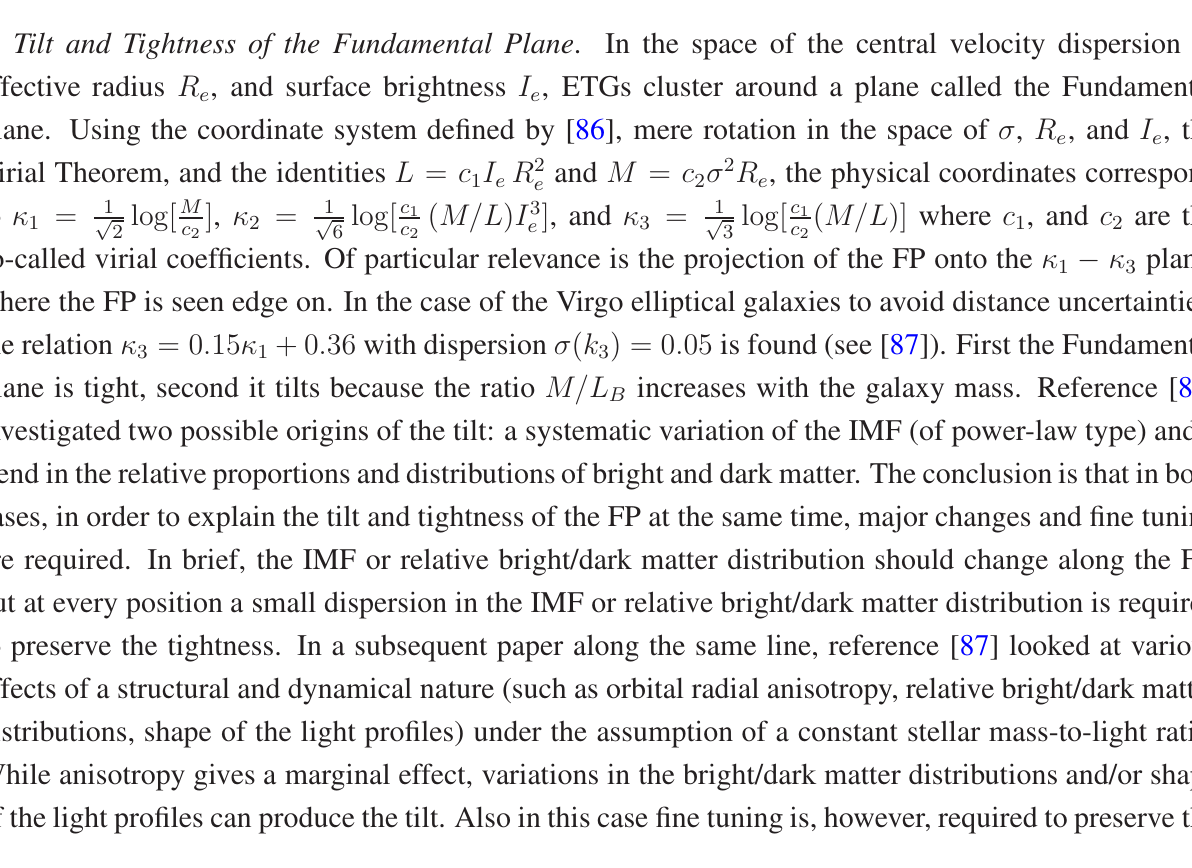
and intensity I . The shaded bar is (B-V) B B are in fractions of the 2 is multiplied + β = 1 is applied. The percentage β 1 2 2